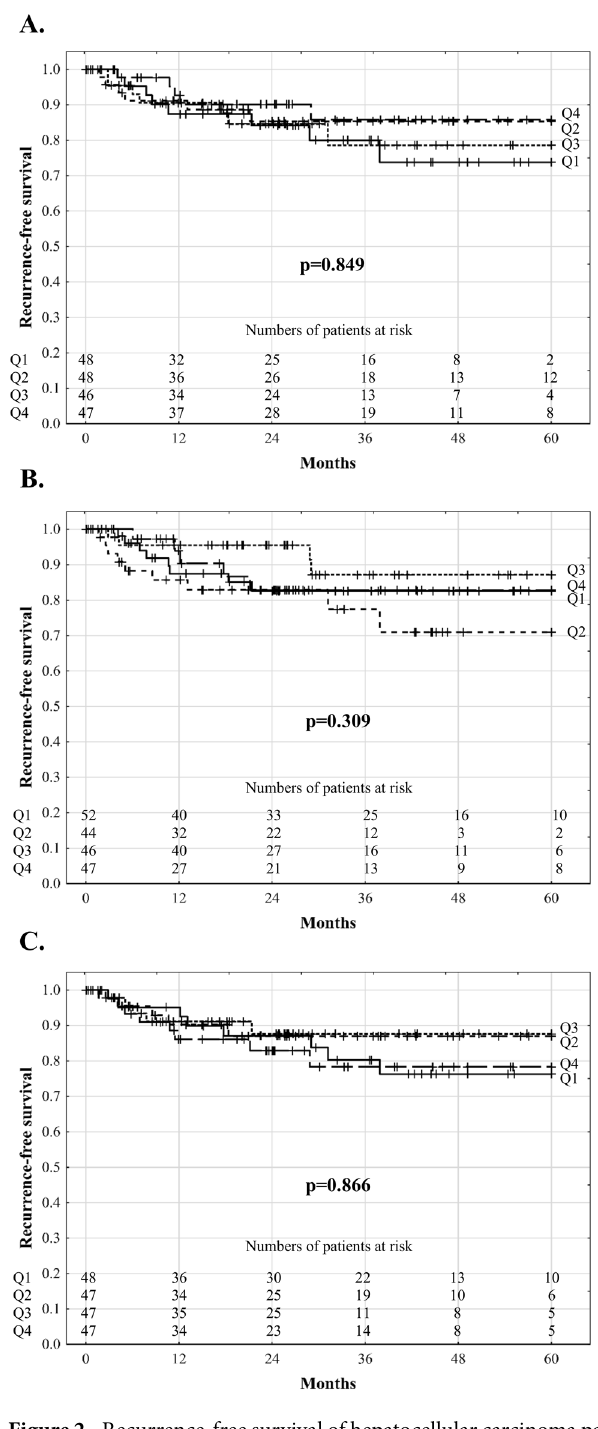
Figure 2. Recurrence-free survival of hepatocellular carcinoma patients after liver transplantation according to quartiles of peak 7-day postoperative bilirubin concentration ( A ), international normalized ratio ( B ), and gamma-glutamyl transpeptidase activity ( C